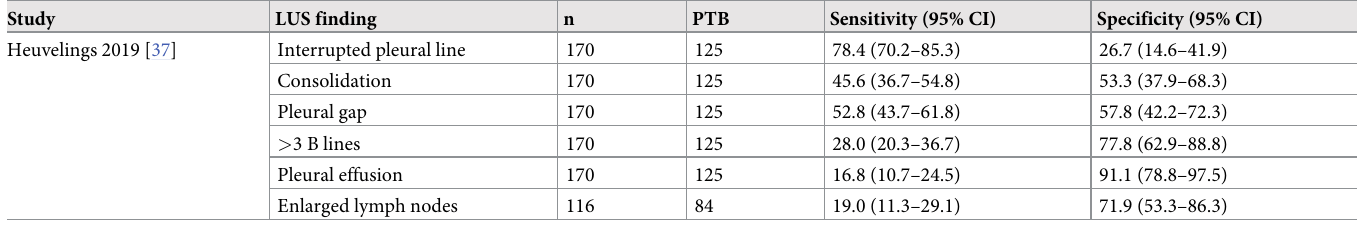
Table 6. Diagnostic accuracy of lung ultrasound findings in